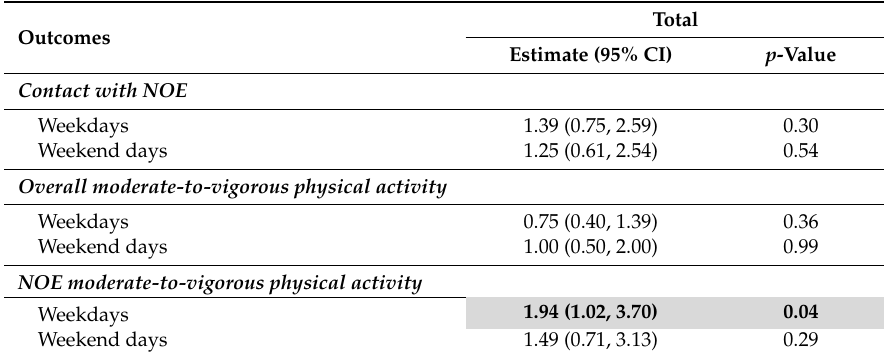
Table A9. Sensitivity models. Adjusted models for residential NOE availability defined as presence of few/a lot of green spaces at 1000 m network buffer (with four green spaces as cut-off